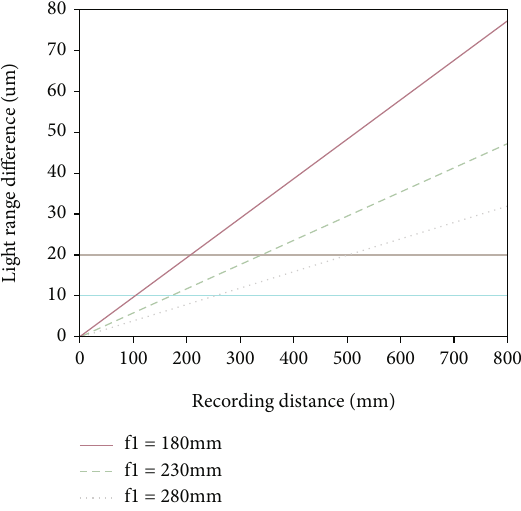
Figure 9: Variation curve of 10 optical range di ff erence δ recording distance z